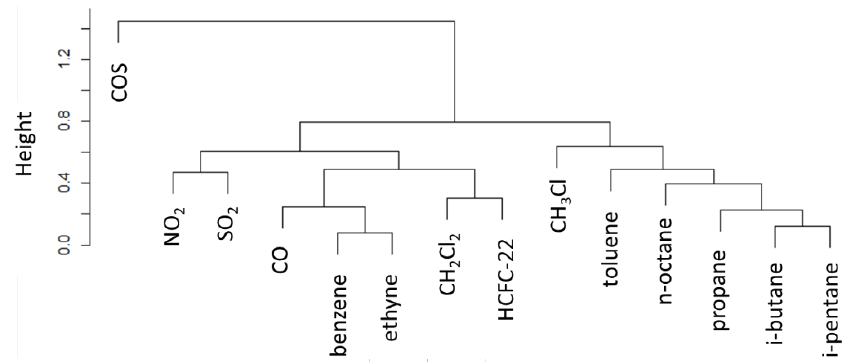
Figure 8. Dendrogram of cluster analysis of atmospheric trace gases for the residuals of the daytime (12:00–18:00 UTC) dataset. Note that the y-axis denotes the cluster distance (indicated as “height”).